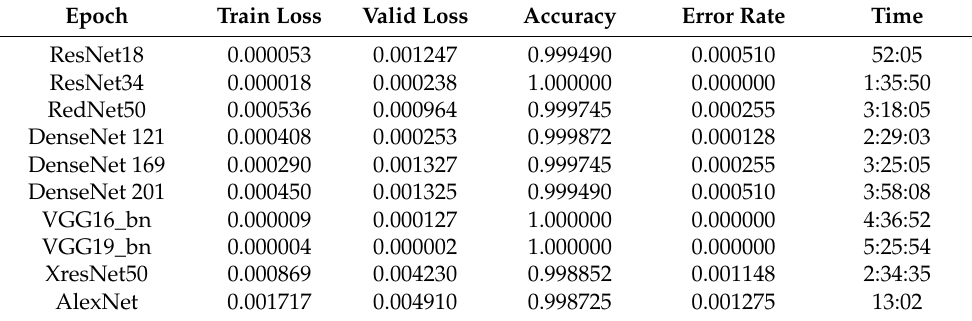
Table 14. Comparison between different systems. Epoch Train Loss Valid Loss Accuracy Error Rate